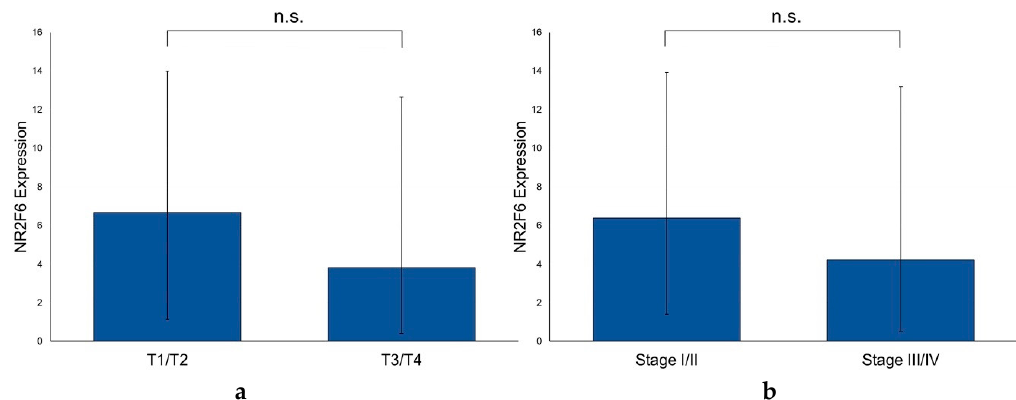
Figure 7. Differences in the NR2F6 expression of different T stages and UICC stages of HNSCC PTs. ( a ) The NR2F6 expression in PTs did not correlate with the T stage (Mann–Whitney test, p = 0.718). ( b ) The NR2F6 expression in PTs did not correlate with the UICC stage (Mann–Whitney test, p = 0.474). (n.s. = not significant).